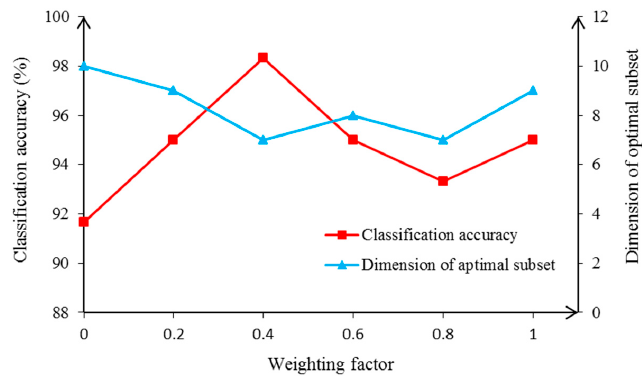
Figure 6. The classification results of FCM under each weighting factor.